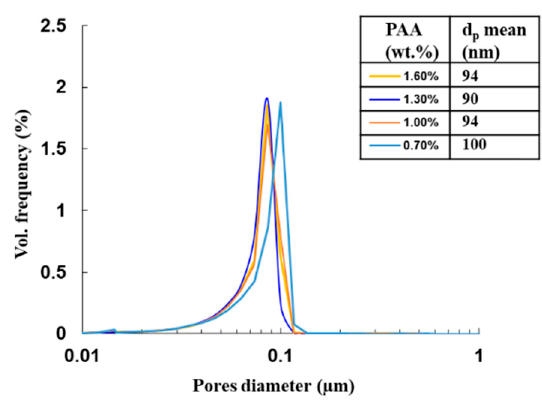
Figure 4. Evolution of the green compact pore size distribution as a function of dispersant amount. Corresponding d p mean values implemented in the model are given in the embedded table.